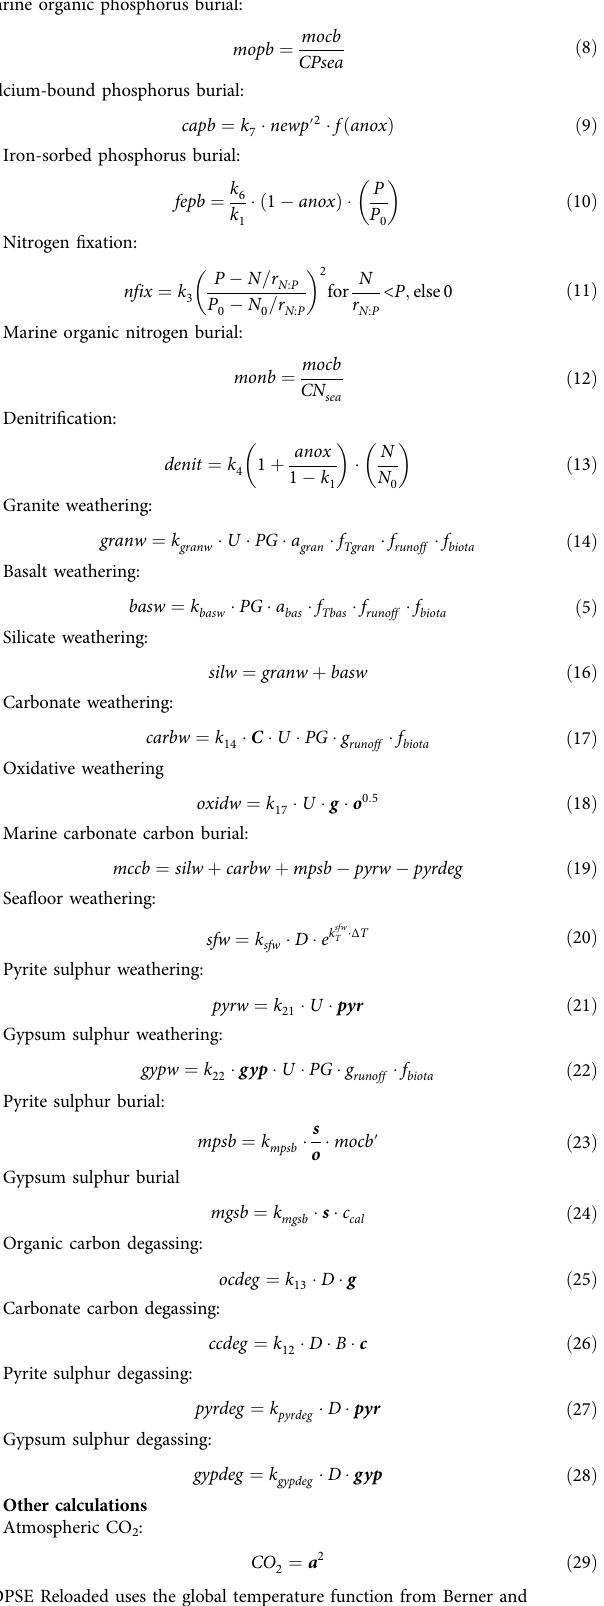
Where time ( t ) is in years from Earth formation (taken to be 4.5 billion years ago). For each rock type, the rubidium-strontium ratio is then calculated such that the observed present-day 87 Sr/ 86 Sr ratio is achieved for each rock type after 4.5 billion